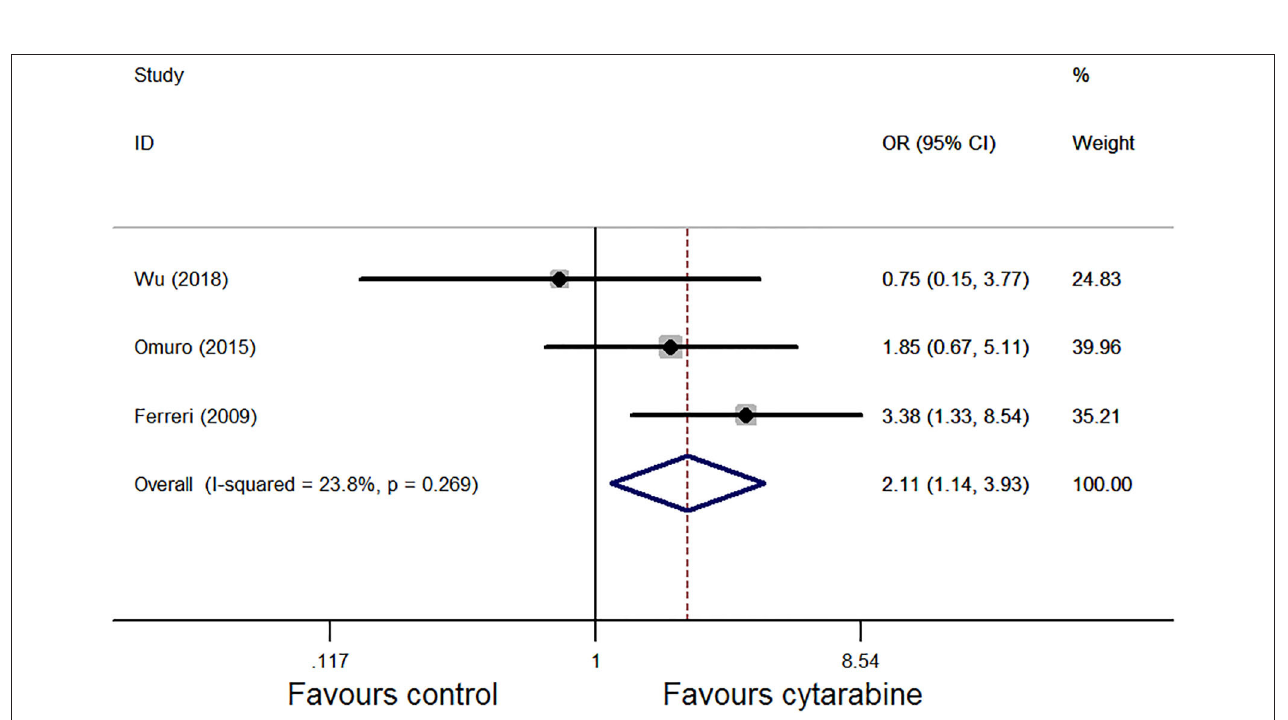
FIGURE 3 | Forest plot of the overall response rate for treatment with the cytarabine group vs. cytarabine-free group (randomized effect model). OR is the effect size.